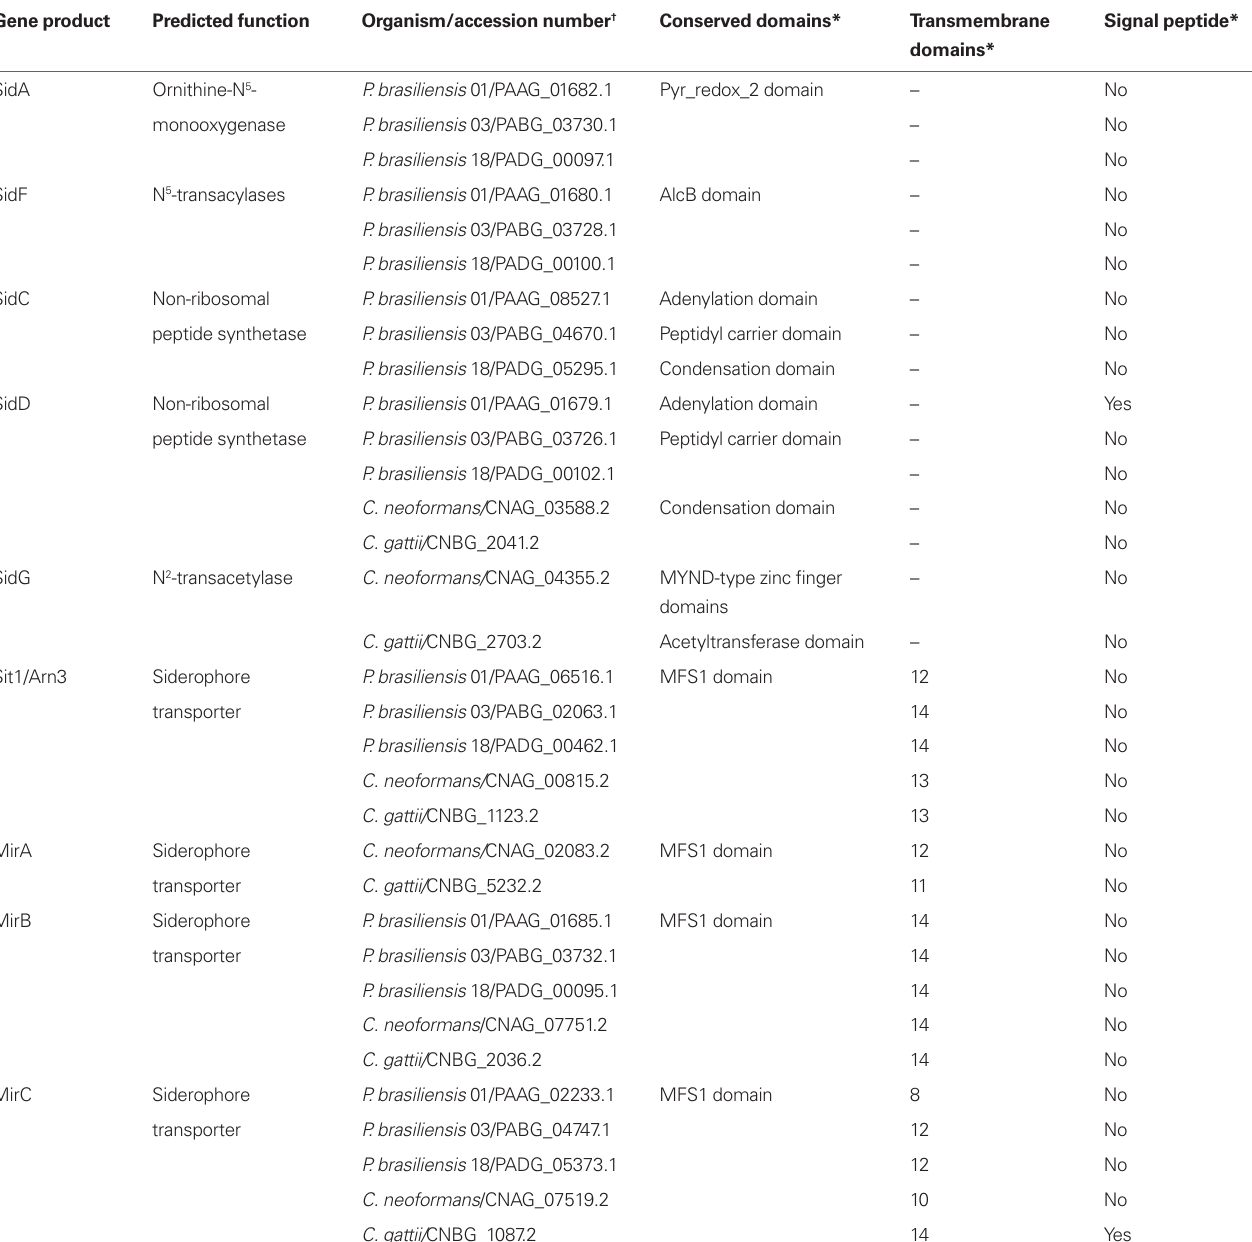
Table A2 | Conserved domains in proteins related to siderophore biosynthesis and to iron uptake by the non-reductive siderophore transport system in P. brasiliensis isolates and Cryptococcus species